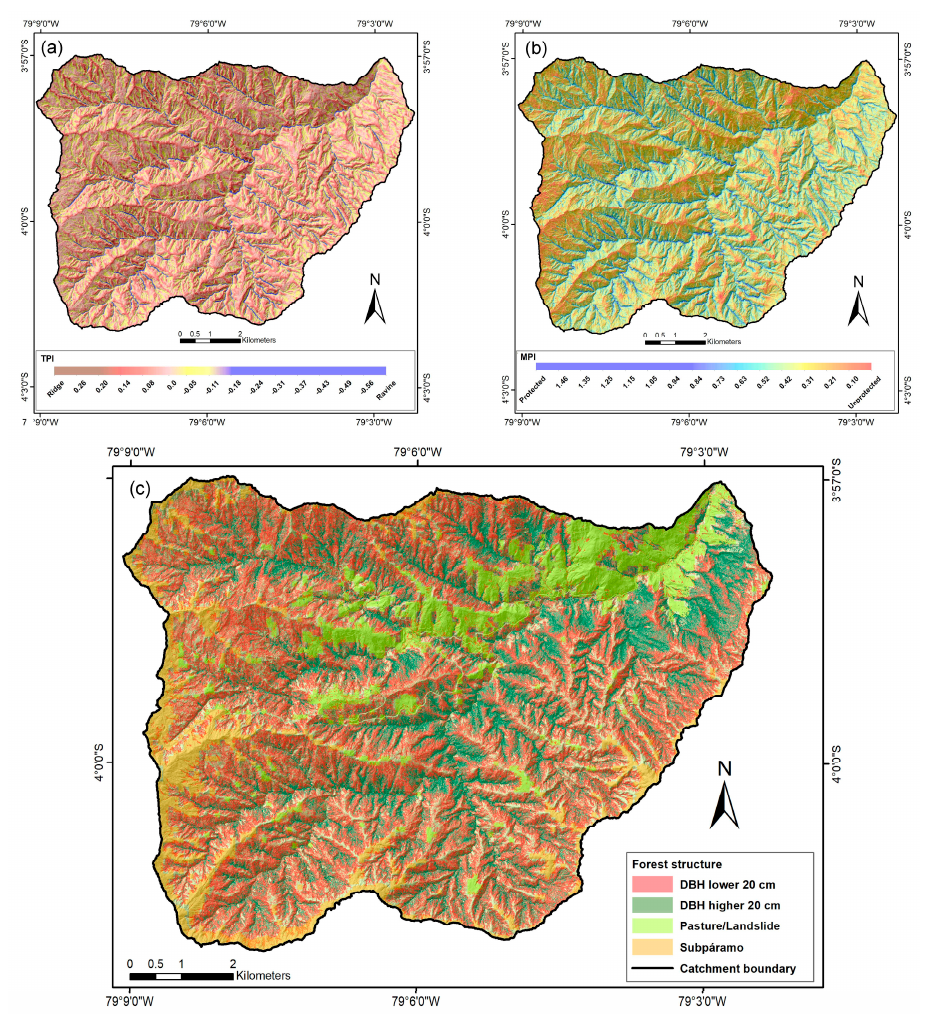
Figure 7. Forest structure detected in the research catchment by means of ( a ) TPI; ( b ) MPI; ( c ) distribution of trees with a DBH smaller than 20 cm (red) and bigger than 20 cm (green).